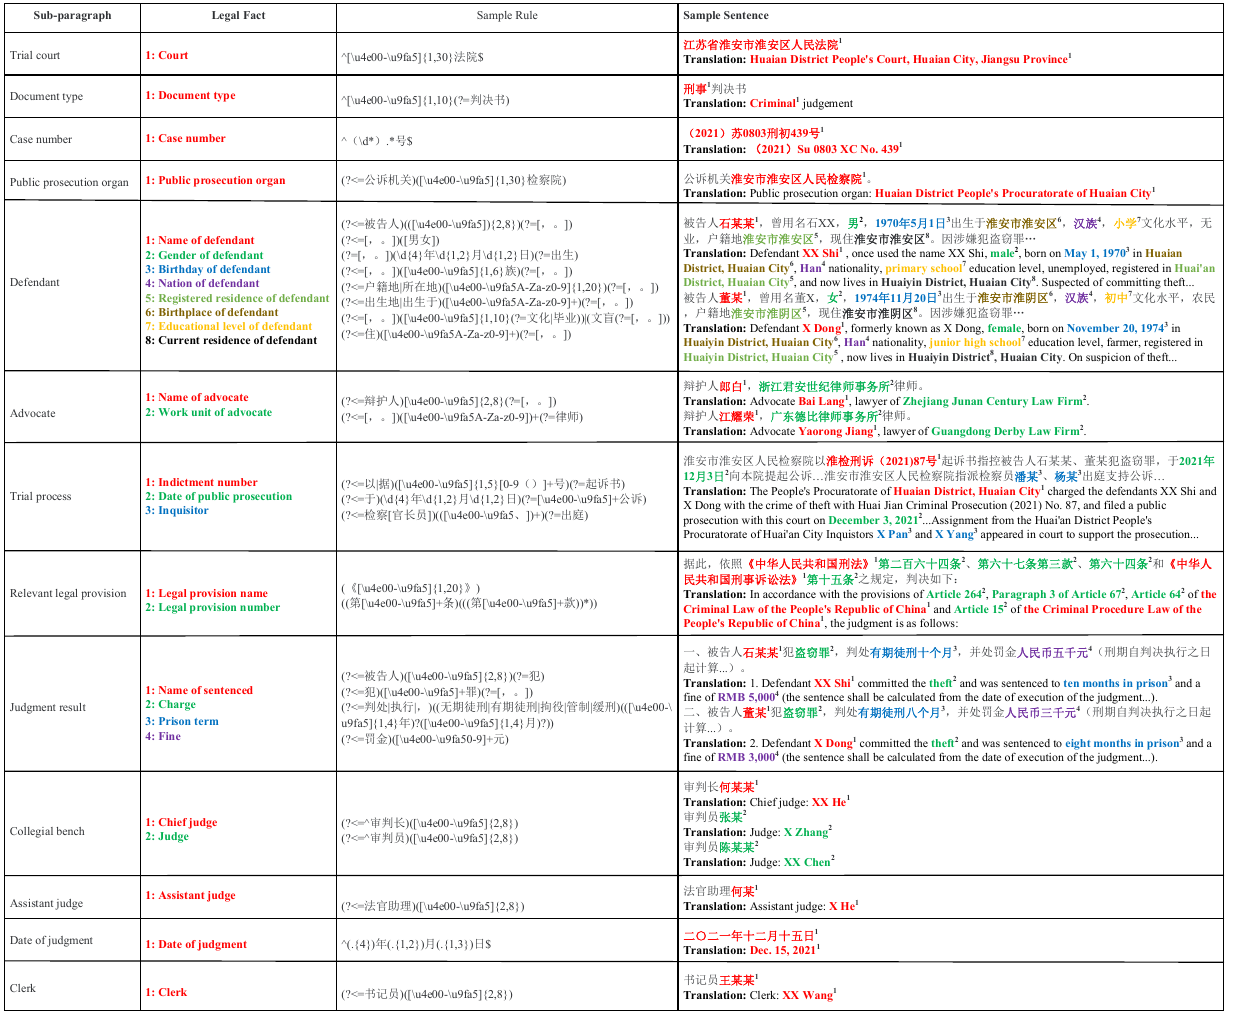
Figure 3. Sample rules and sentences for extracting legal facts from each sub-paragraph. The extracted legal facts are distinguished by color and the superscript numbers.